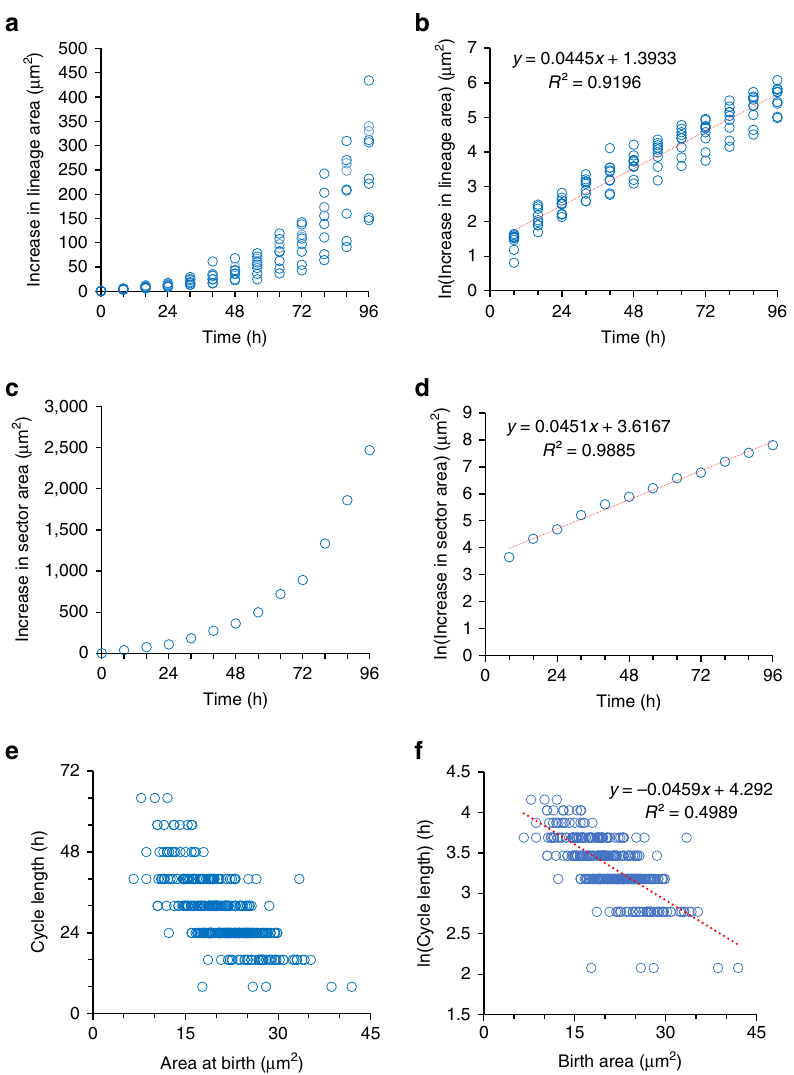
Figure 1 | Cell size control is required to maintain cell size in the SAM. ( a ) Graph showing the increase in lineage area of the nine most central cell lineages in the central region of the SAM over 96h of growth. Each lineage begins with a single cell. ( b ) Natural log transformed data from graph a . Linear regression indicates an exponential relationship. ( c ) Increase in total area of the lineages shown in parts a , b . ( d ) Natural log transformed data from graph c . Linear regression indicates an exponential relationship. ( e ) Graph showing relationship between cell area at birth and cell cycle length for 182 cells from the central zone. ( f ) Natural log transformed data from graph e . Red line shows (Fig. 2a–c). In 46 cases (23%), daughters divided synchronously, but in most cases (125/182) daughters divided asynchronously with up to 48 h difference in cell cycle length (Fig. 2b–d). Notably, sisters that divided asynchronously had a larger mean difference in area at birth than those that divided synchronously (Fig. 2e) and in all but eight cases (4% of asynchronous divisions), the larger daughter divided first and on average added a smaller area to its birth size (Fig. 2e). Accordingly, a significant number of asymmetric pairs ( 4 5 m m 2 difference in area) were closer in size at division than at birth (binomial test, 72/105, P ¼ 3.885e (cid:2) 05 ). Differences in size at birth therefore appear to be corrected mainly by changes to cell cycle length through an inverse relationship that results in larger, faster cycling cells and smaller, slower cycling cells.